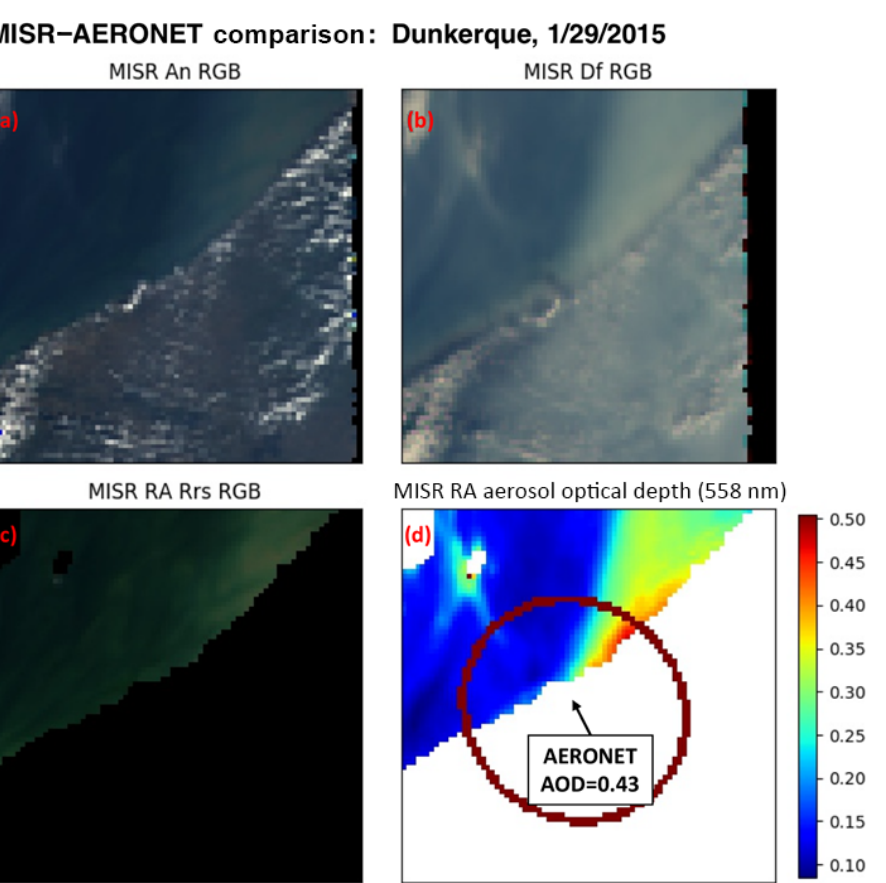
Figure 6. Example set of 80 × 80 pixel MISR aerosol retrievals centered over the Dunkerque AERONET site on 29 January 2015, showing the effects of scene variability on the MISR–AERONET comparison. Brightness-enhanced true-color images for the (a) nadir and (b) 70.5 ◦ forward camera. (c) Brightness-enhanced true-color image of MISR-RA-retrieved R rs and (d) MISR-RA-retrieved over-water AOD. The red circle in panel (d) represents the 25km averaging window used for MISR and AERONET comparisons. The ± 30min average AERONET 558nm (interpolated) AOD is provided for context. Cloud–land masking has been applied to panels (c) and (d)